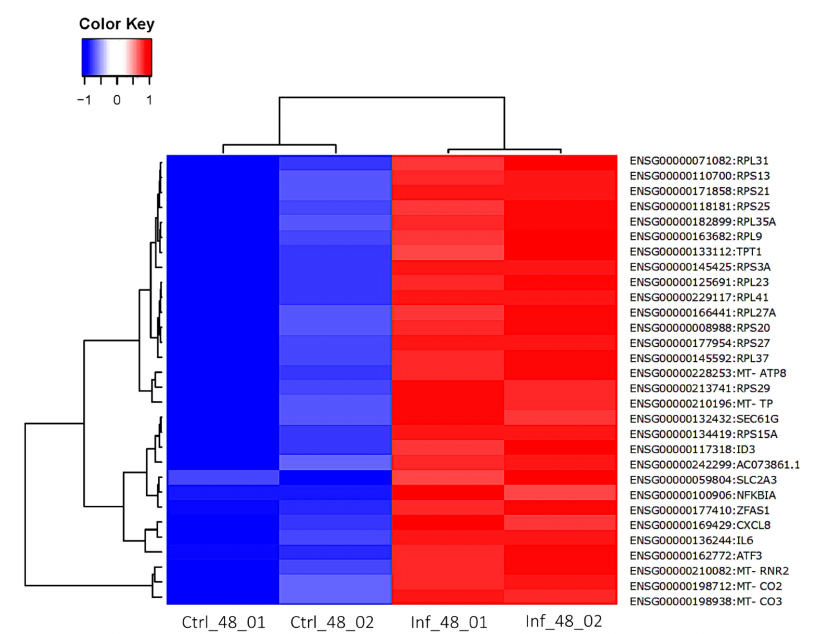
Figure 14. Heatmap generated from the log 2 FC of the top 30 DEGs at 48 hpi. Blue and red colors indicate low and high gene expression, respectively. Gene IDs are indicated on the right side of the heatmap. Columns represent the samples and time points post infection, while rows represent individual genes. The phylogenetic tree above the heatmap demonstrates the hierarchical clustering of the samples. The relationships between the genes are shown on the left tree. For each gene symbol, the respective log 2 FC and other information can be found in Table